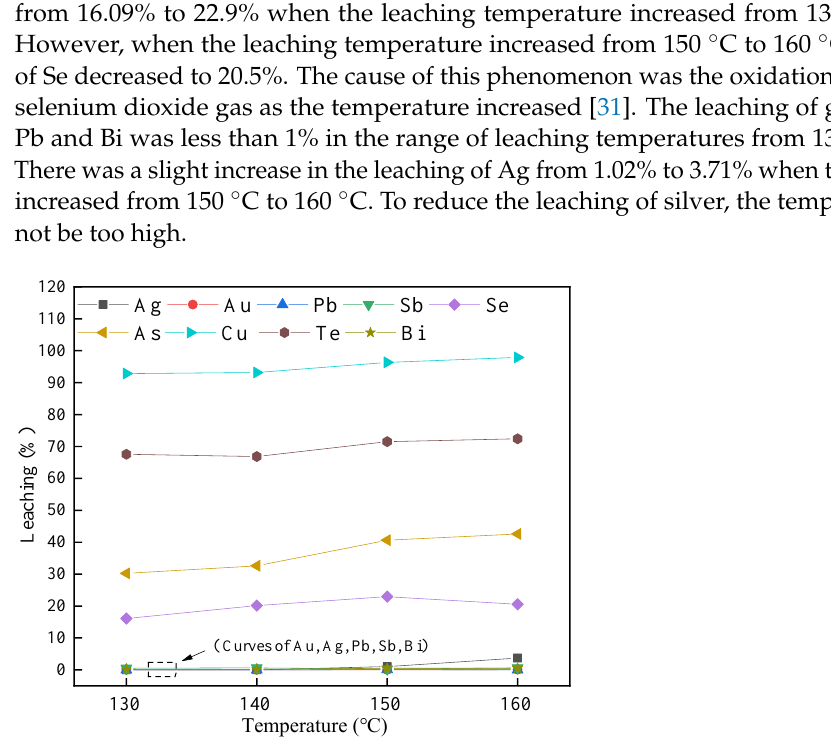
Figure 7. Effect of the leaching pressure on the leaching of each element (t = 2 h, T = 150 °C and H 2 SO 4 = 250 g/L).